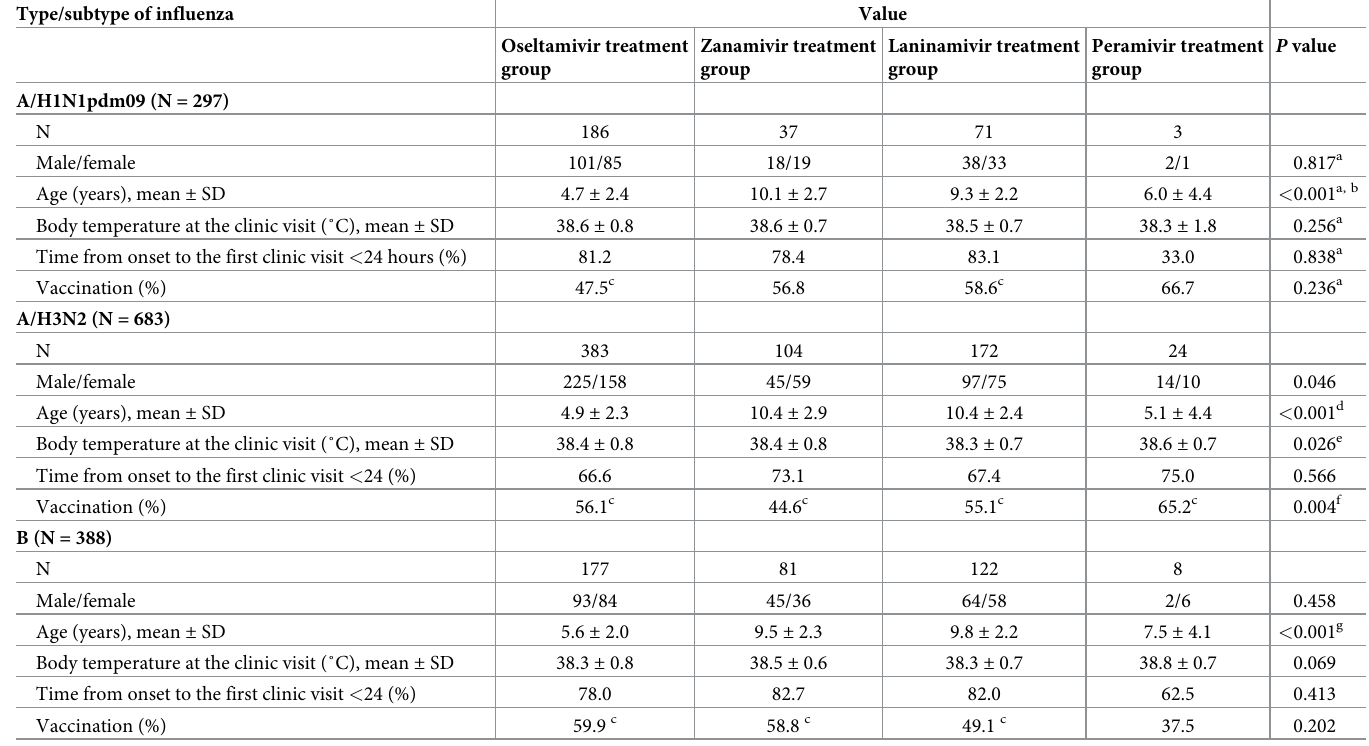
Table 2. Patients’ characteristics by treatment groups and